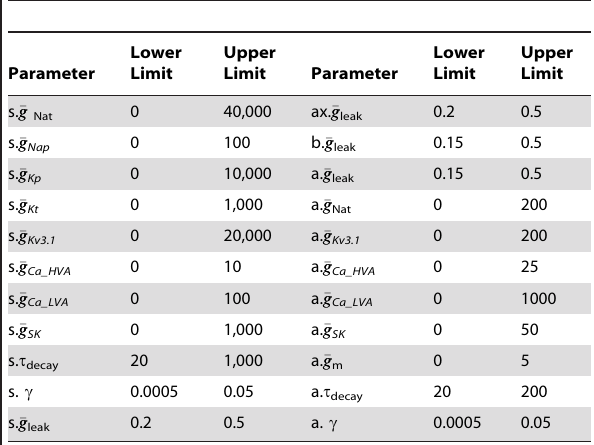
Table 2. Parameter limits for ion channel density and Ca 2 + dynamics parameters used in the evolutionary